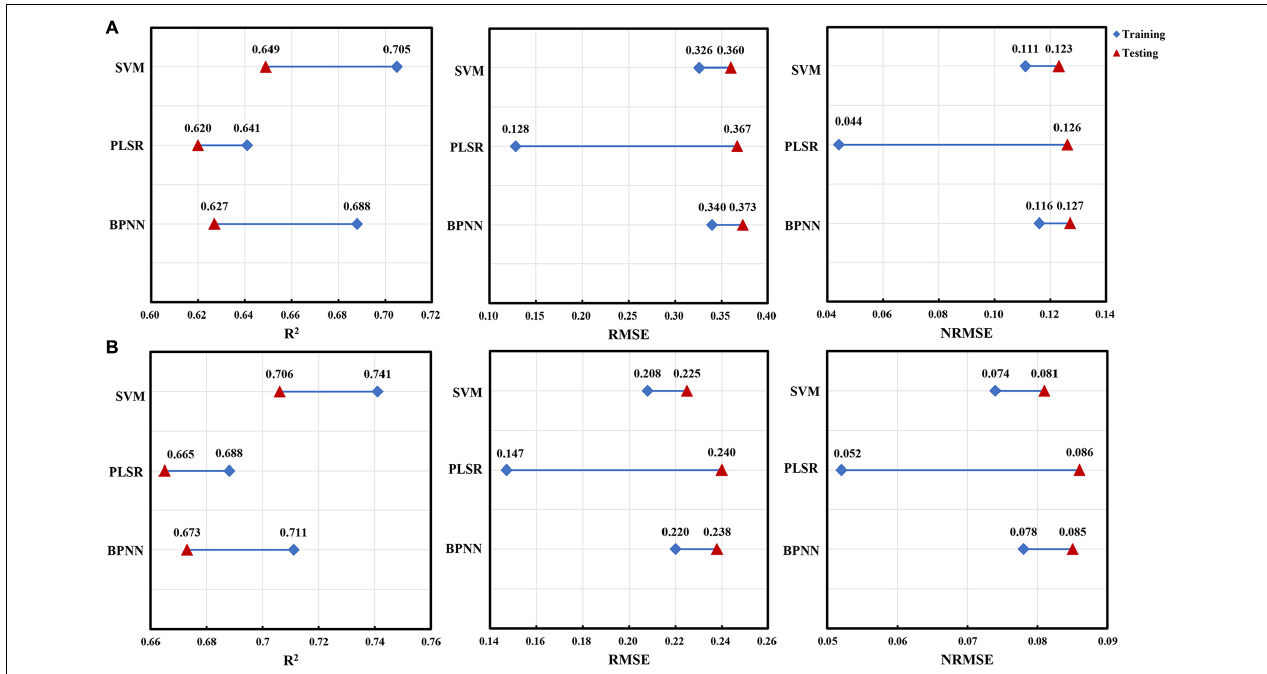
FIGURE 9 | The difference between the performance indicators for LAI estimation of red bean and mung bean using three machine learning methods within training and test datasets. (A) Red bean; (B) mung bean.